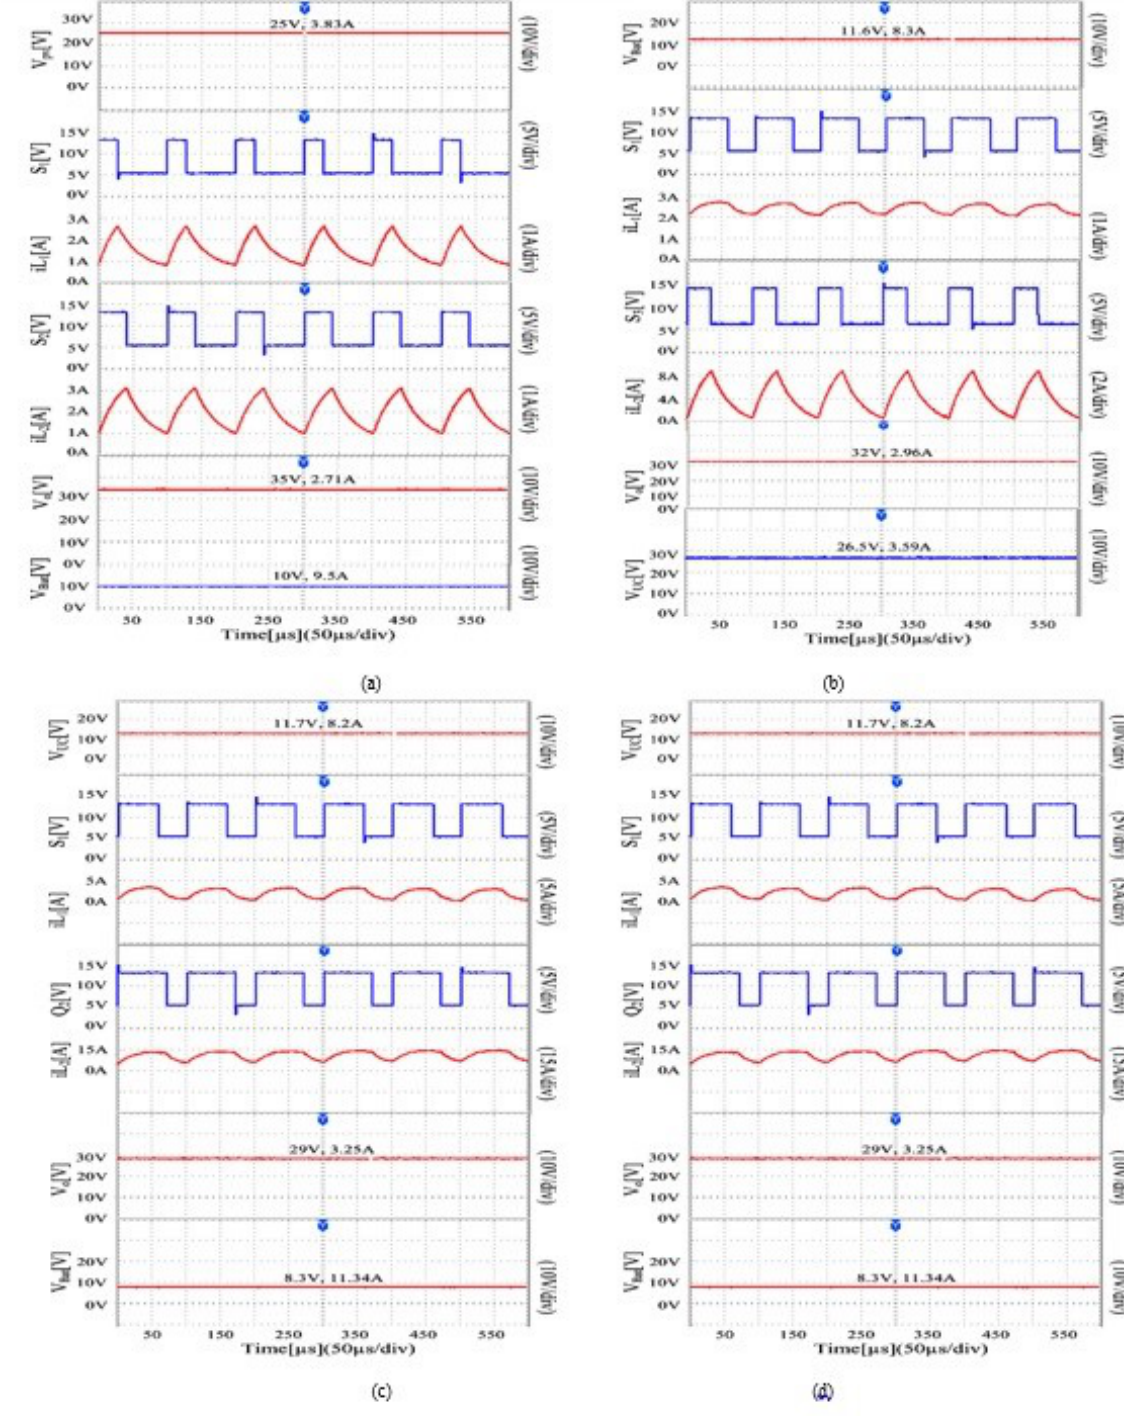
Fig. 6. Experimentation results of (a) Case 1 (b) Case 2 (c) Case 3 (d) Case